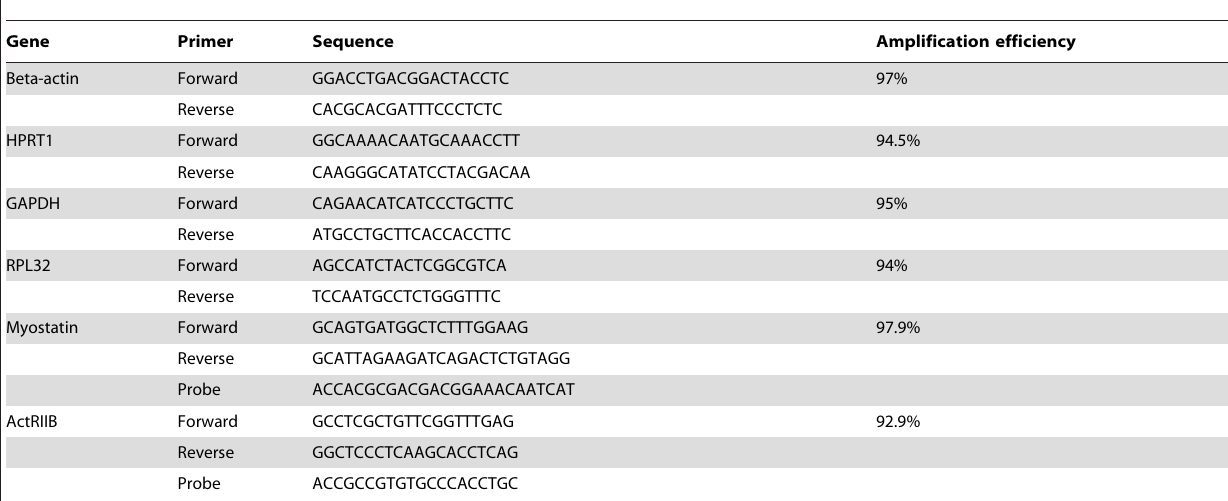
Table 3. Nucleotide sequences of primers and probes used in the current study.